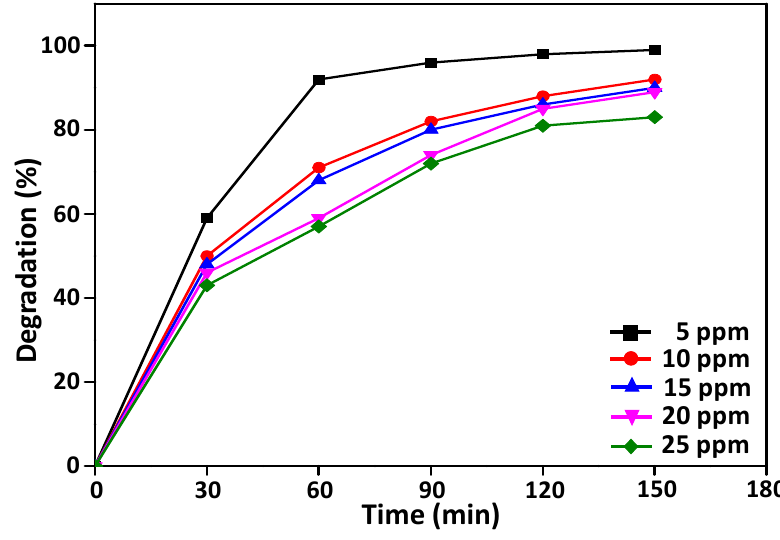
Figure 9. Degradation of MB with varying dye concentration and a constant catalyst load (B1).